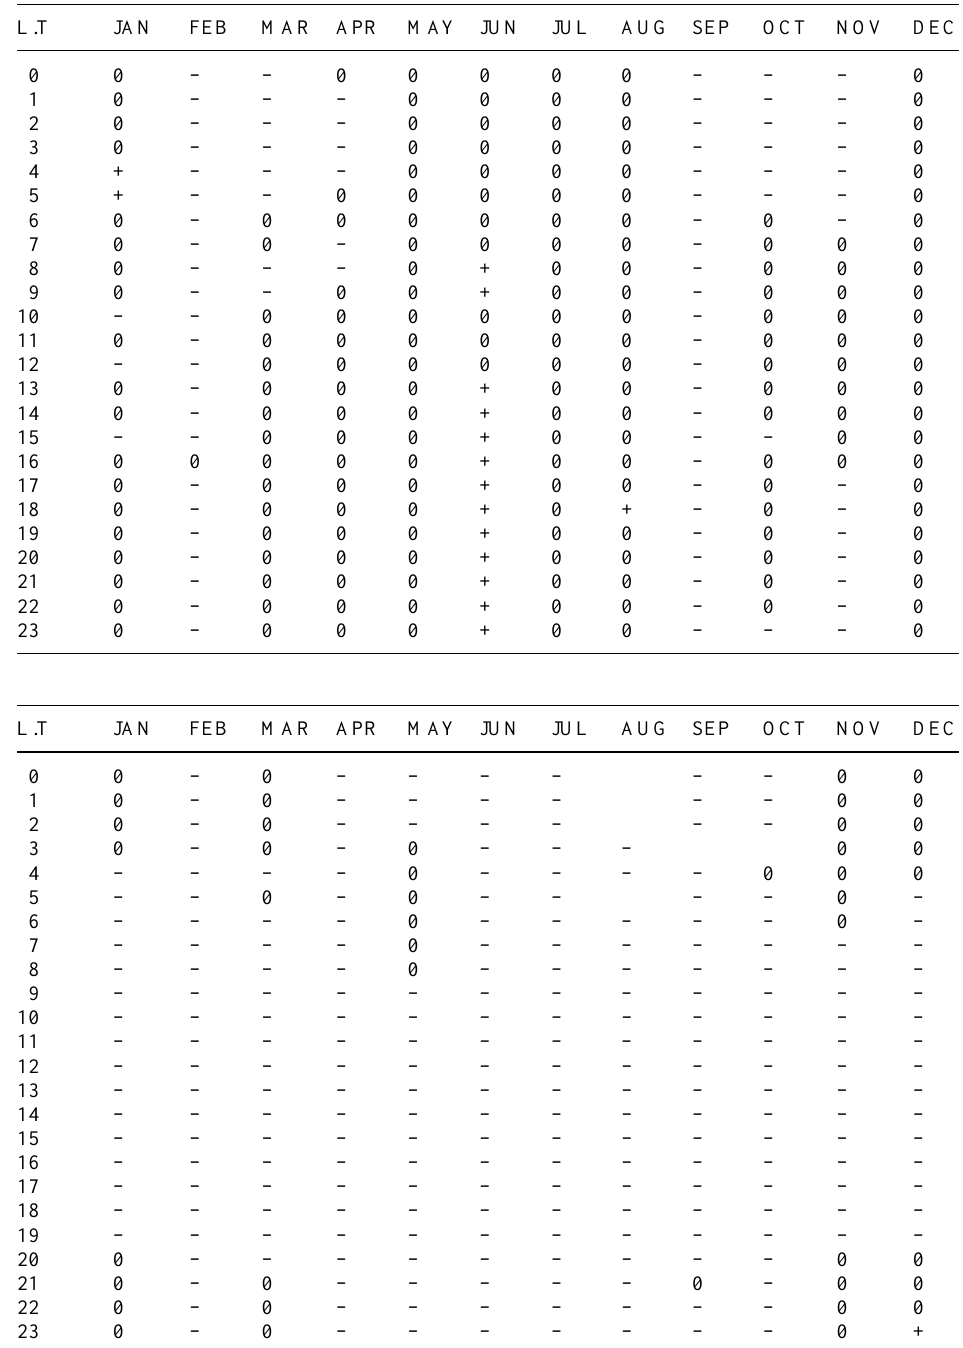
Table 1. Hours and months for which the coefficient a 3 of the cubic polynomial term for fo F2 is significant in the case of Slough data, positive, –: a negative, +: a 3 3